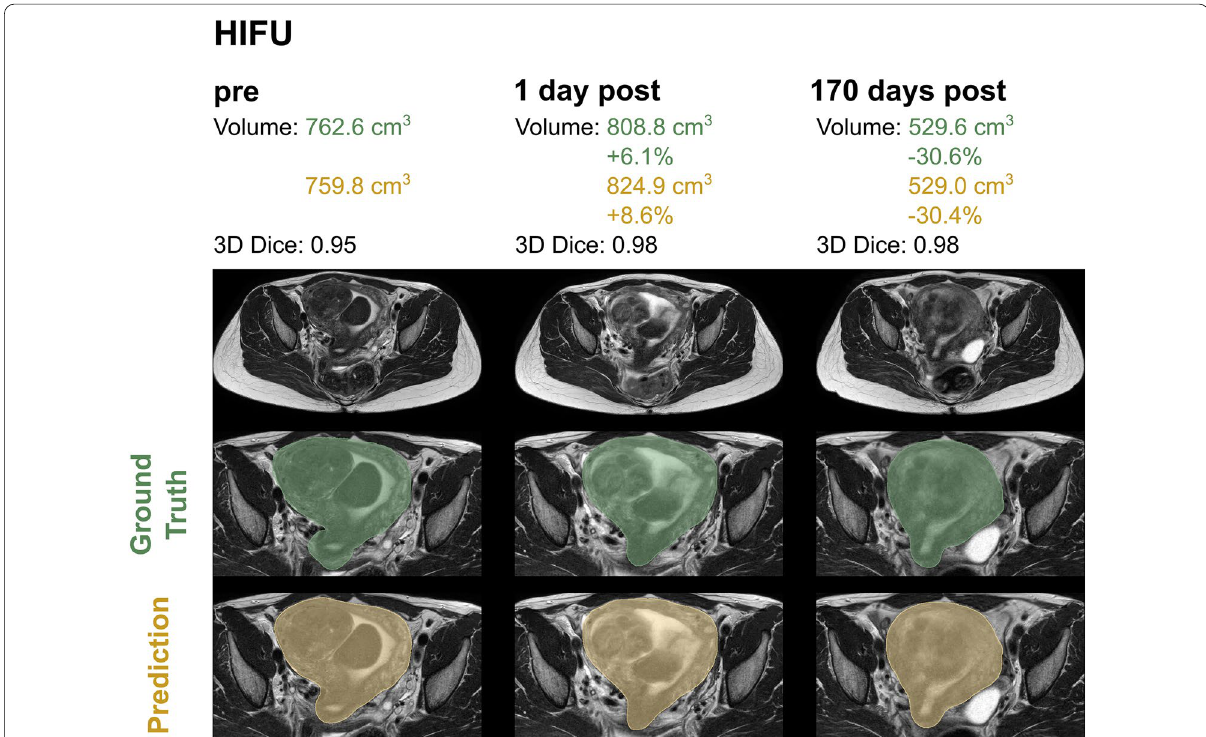
Fig. 2 Uterine segmentation in a patient undergoing HIFU therapy: before treatment, one day after treatment and 170 days after treatment. Automatic segmentation achieved with the default 3D nnU-Net is shown in yellow and ground truth segmentation validated by a board-certified radiologist in